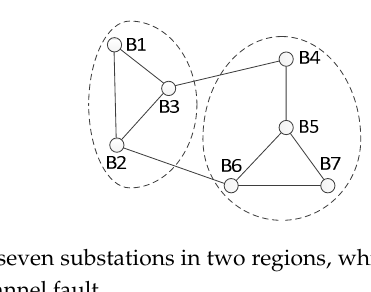
( c ) Figure 4. Corrections under different situations: ( a ) The circuitous process of information when it is acceptable to circuit within its own region; ( b ) The circuitous process of information when the help of other regions is necessary to circuit; ( c ) The partition correction when the delay will be too long if circuiting within its own region or with the help of other regions. 3.3.2. Primary Substation Correction for Single-Point Failure After completing the selection of the primary substation, the regional protection configuration must consider setting a dual or even triple primary substation decision unit according to the importance of the protection object. When the primary substation has serious faults such as a DC fault, it is necessary to set up other secondary substations in the area as the backup primary substation. The principle of selecting the backup primary substation is based on the connection degree of each secondary substation in the region. The secondary substation with the highest connection degree is selected as the backup primary substation. When the communication between the local secondary substation and the primary substation is interrupted, the backup primary substation will automatically switch to the primary substation to realize the function of regional protection, so as to deal with the single-point failure risk of the system. 4. Partition Process